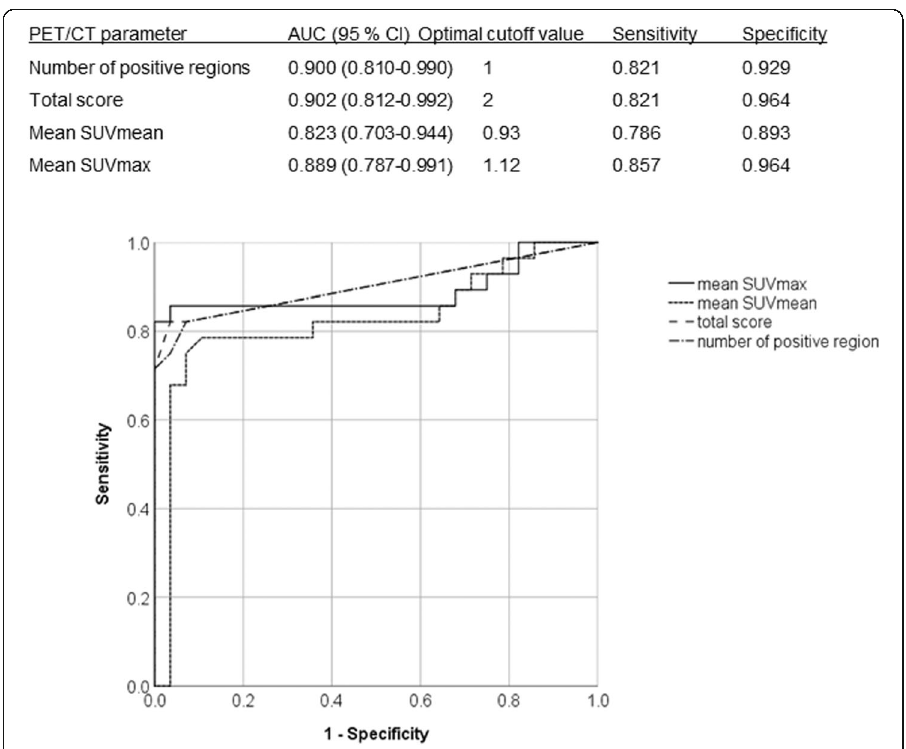
Fig. 2 Receiver operating curve analysis for discriminating patients with PM/DM from control patients using 18 F-FDG PET/CT